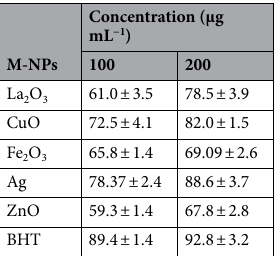
Table 1. Antioxidant activity (%) of different metal nanoparticles against DPPH at 100 and 200 μg mL −1 . Data are given as mean ± SE (n = 3). M-NPs: Metal